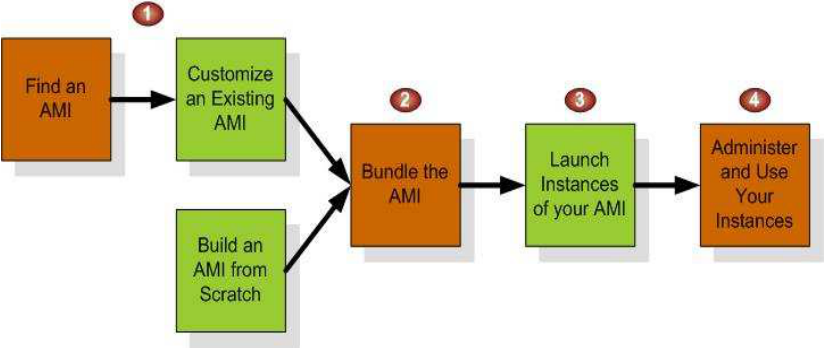
Figure 4: Amazon Elastic Cloud Compute (EC2) Flow (Source: